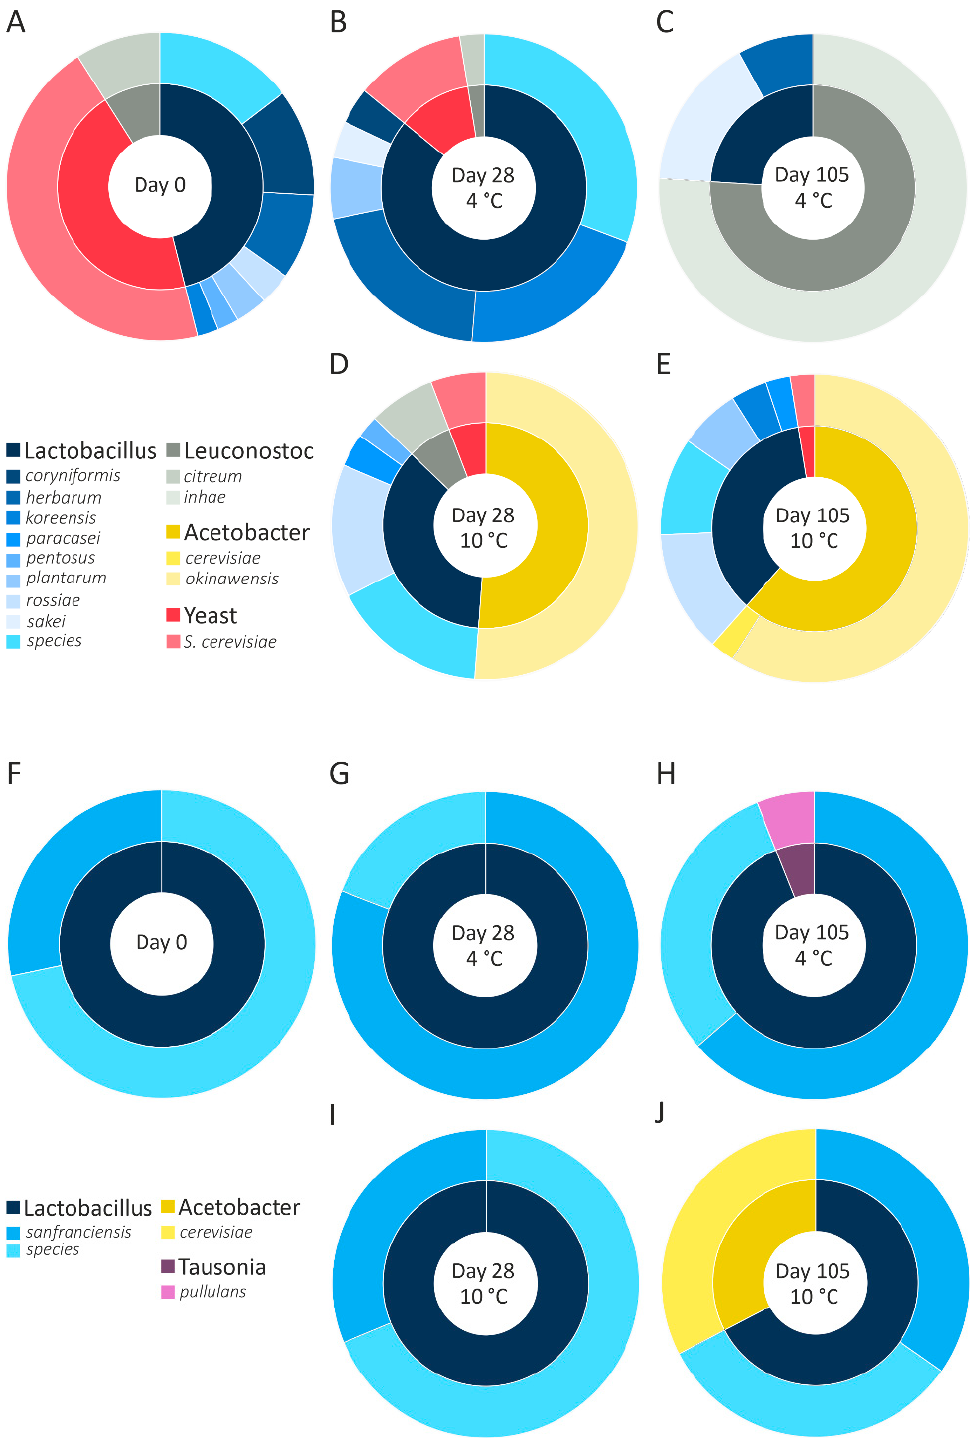
Figure 4. Microbiome of sourdough. Inner circle, genus; outer circle, species. ( A ) Wheat sourdough starter cultures. ( B, C ) Wheat sourdough, 4 °C. ( D, E ) Wheat sourdough, 10 °C. ( F ) Rye sourdough starter cultures. ( G, H ) Rye sourdough, 4 °C. ( I, J ) Rye sourdough, 10 °C.